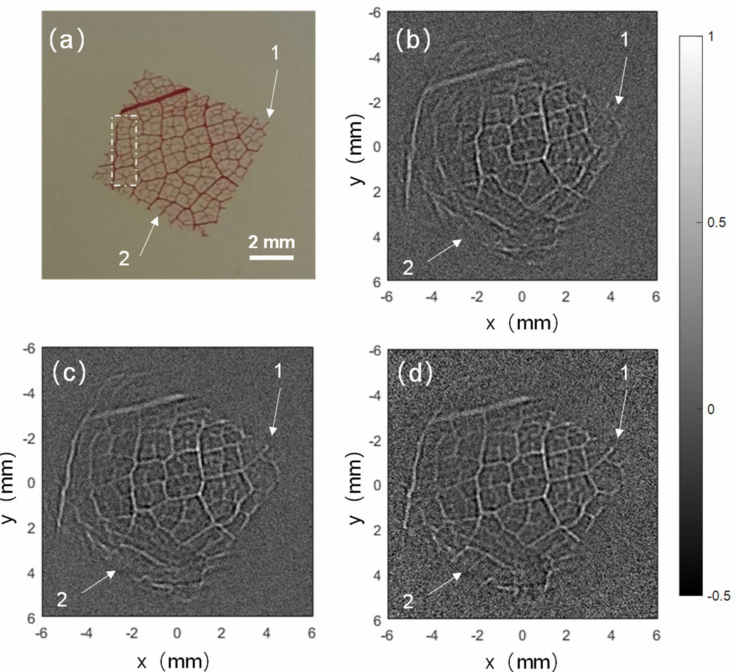
Figure 8. Experiment results for imaging a piece of leaf veins with different reconstruction methods. ( a ) Photo image of the leaf veins; ( b – d ) are the reconstructed images with the conventional BP algorithm, the TDC-BP algorithm and the SIR-BP algorithm,